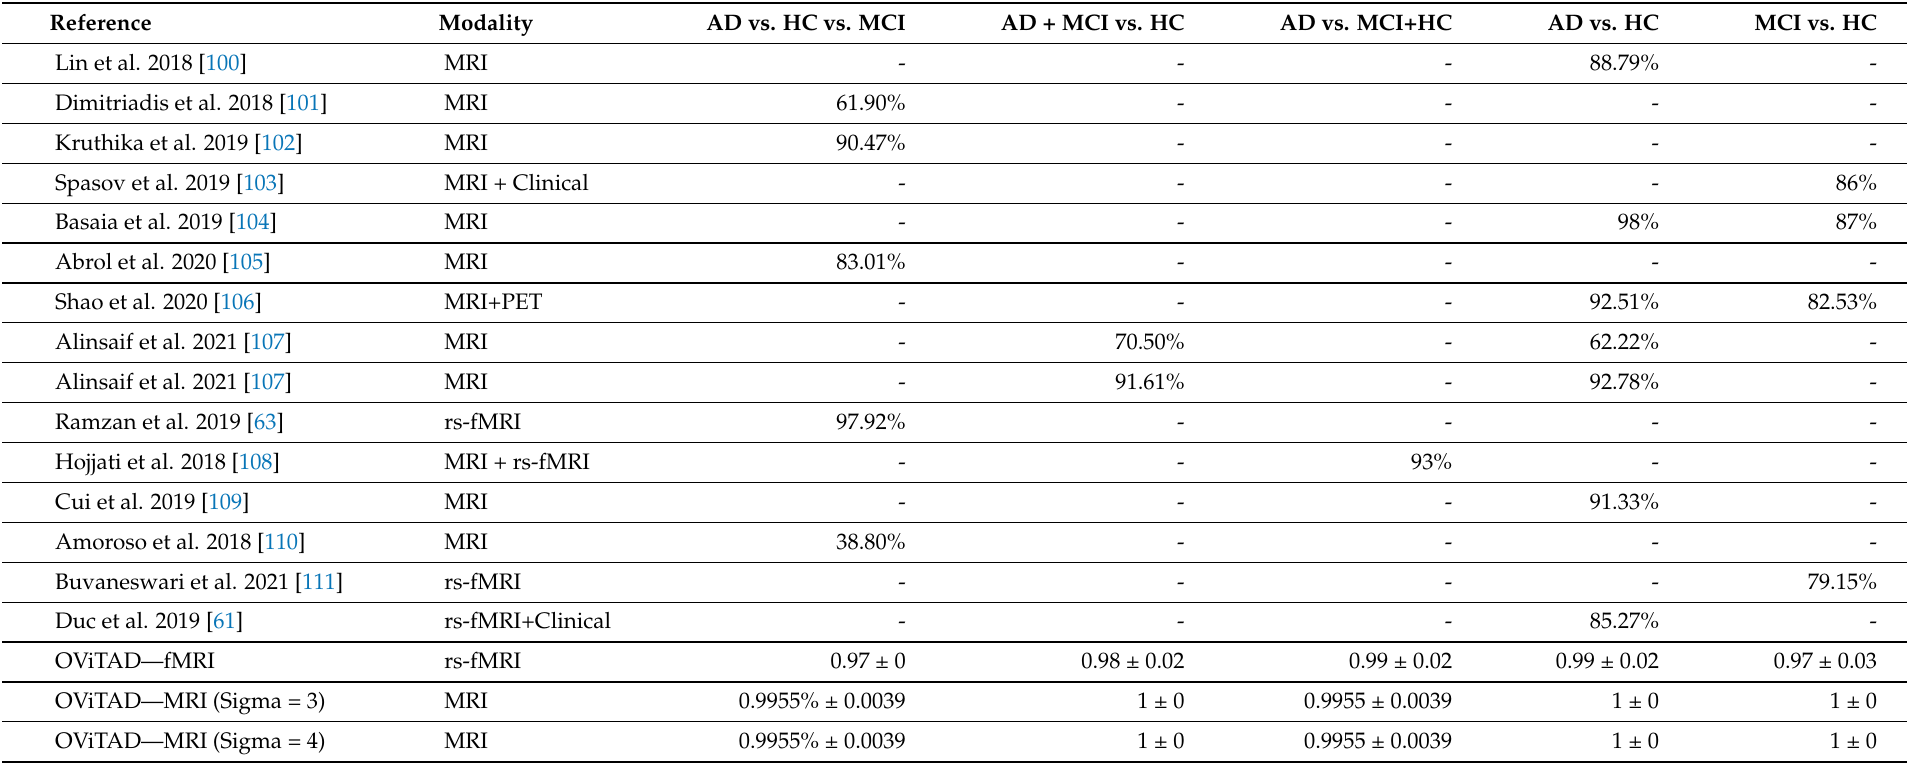
Table 5. Comparison between recent studies of Alzheimer’s classification using ADNI and our OViTAD. The analysis shows that our study addresses a broader classification aspect with novel vision transformer technology, and our model performance outperformed the literature. Further details is found at Table